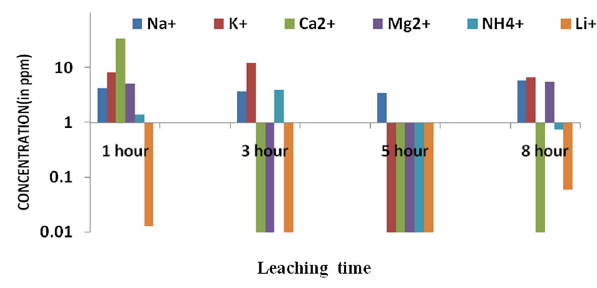
Fig. 4 Change in concentration (in ppm) of cations in aqueous leachates of Ledo coal (LC-60A) with leaching time (in hour) at 25 (cid:3) C